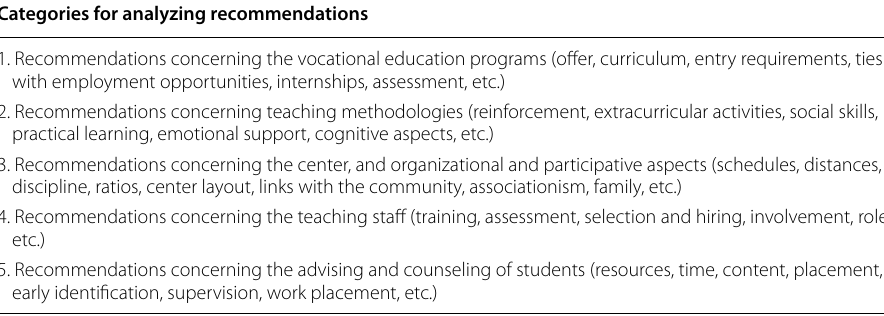
Table 2 Categories used for organizing recommendations Categories for analyzing